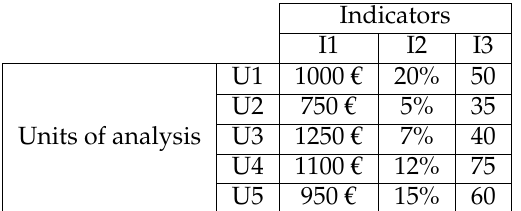
Figure A3. Data for an hypothetical example with three indicators and five